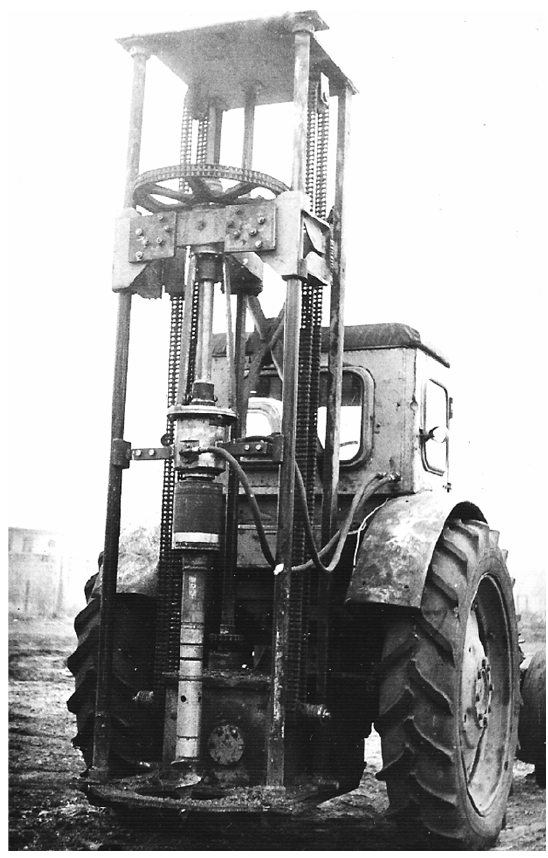
Fig. 1. Standard working equipment of gasodynamic soil loosening